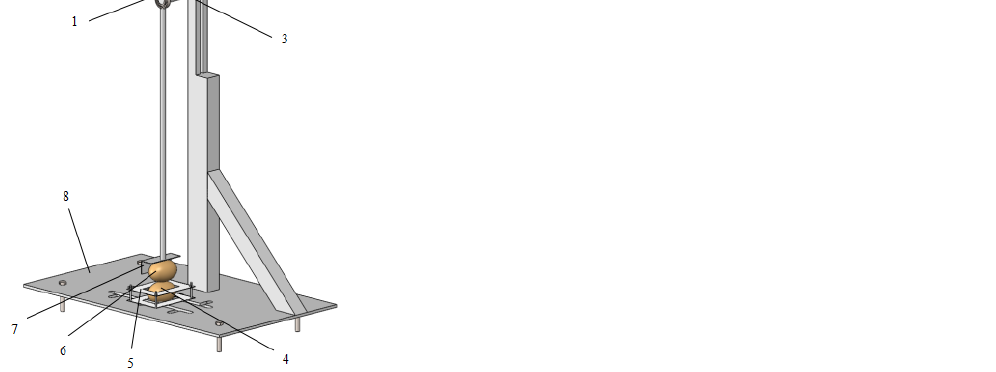
Figure 1. Single pendulum friction test device. 1. Rolling bearing. 2. Adjusting nut. 3. Supporting shaft. 4. Friction material. 5. Fixture 1. 6. Potato. 7. Fixture 2. 8. Test bench support.